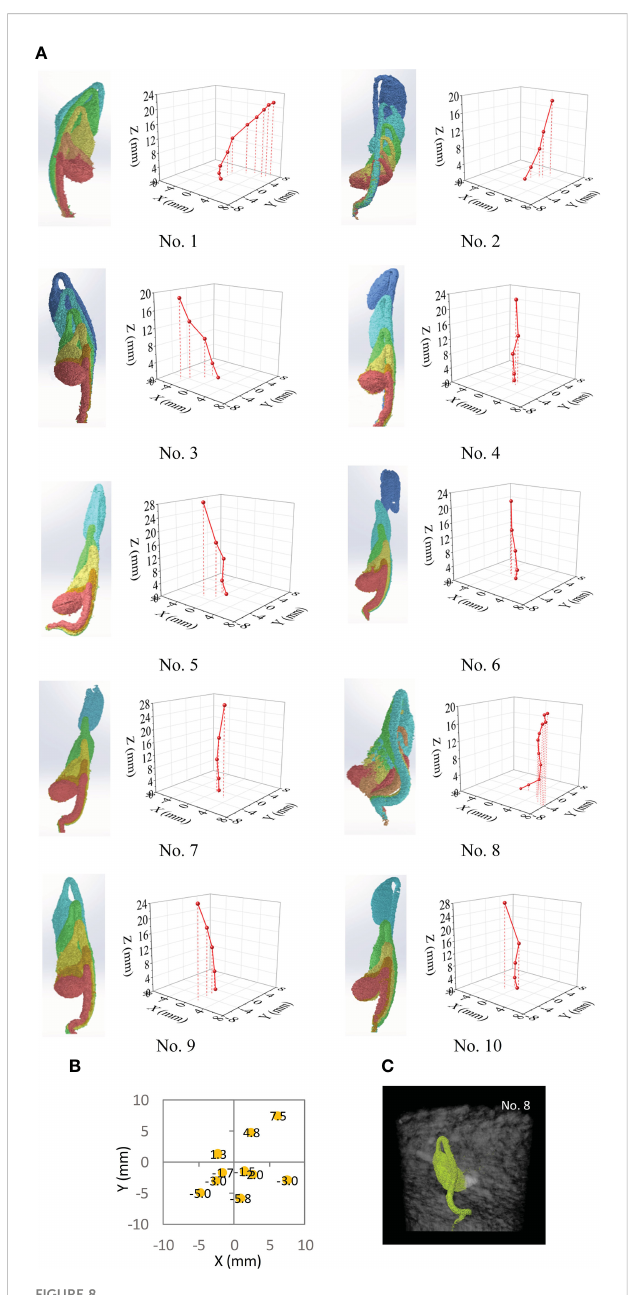
FIGURE 8 Analysis results from CT images and the path characteristics of 10 seedling over time. (A) Overlapped images of seedling and measured locations of hypocotyl apex of the seedling at different times. (B) Final location of hypocotyl apex on the X-Y plane at the time of emergence for 10 seedlings; the initial position was at the origin of X-Y plane. (C) A scan image of seedling from Test No. 8.